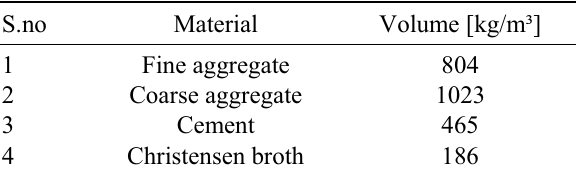
Table 1. Composition of concrete